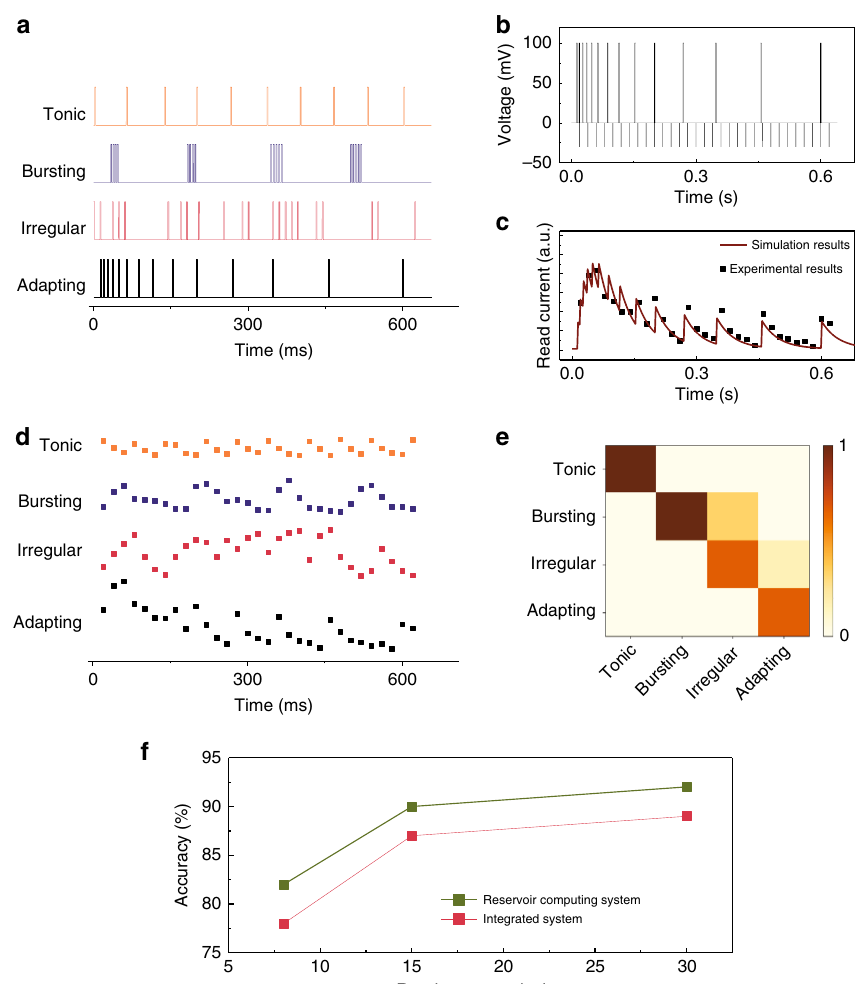
Fig. 3 Neural fi ring pattern recognition. a Typical spike trains corresponding to four common neural fi ring patterns. b Waveform of a spike train applied to the memristor during the measurements, including spike inputs (the “ Adapting ” pattern in this example) and the read pulses ( − 30 mV, 0.5 ms, with an interval of 20 ms). c Evolution of the read current (black dots) measured from the device when excited by the spike train in b . The experimental results agree well with the simulation results (solid curve) based on a dynamic memristor model 15,20 . d Evolution of the memristor read current for the spike trains shown in a . e False color confusion map showing the experimentally obtained recognition results. The occurrence probability for each fi ring pattern is represented by the colors shown in the color scale. f Simulated neural fi ring pattern recognition accuracy at different readout layer sizes, for the integrated system that integrates the input data over a fi xed time period, and the memristor-based reservoir measured memristor response to a streaming spike train is shown in Fig. 4c and d, with clear correlations to the fi ring patterns and transitions. Figure 4e shows the outputs from the network over time. The arrows highlight the moments when the pattern transitions were detected by the network, corresponding to the transitions highlighted by the dashed boxes in Fig. 4c, d, such as I “ Tonic → Bursting ” , II “ Bursting → Irregular ” and III “ Irregu- lar → Adapting ” . The prediction results for the entire spike train and the manually labeled ground truth are shown in Fig. 4f. One can see that most of the prediction results are consistent with the